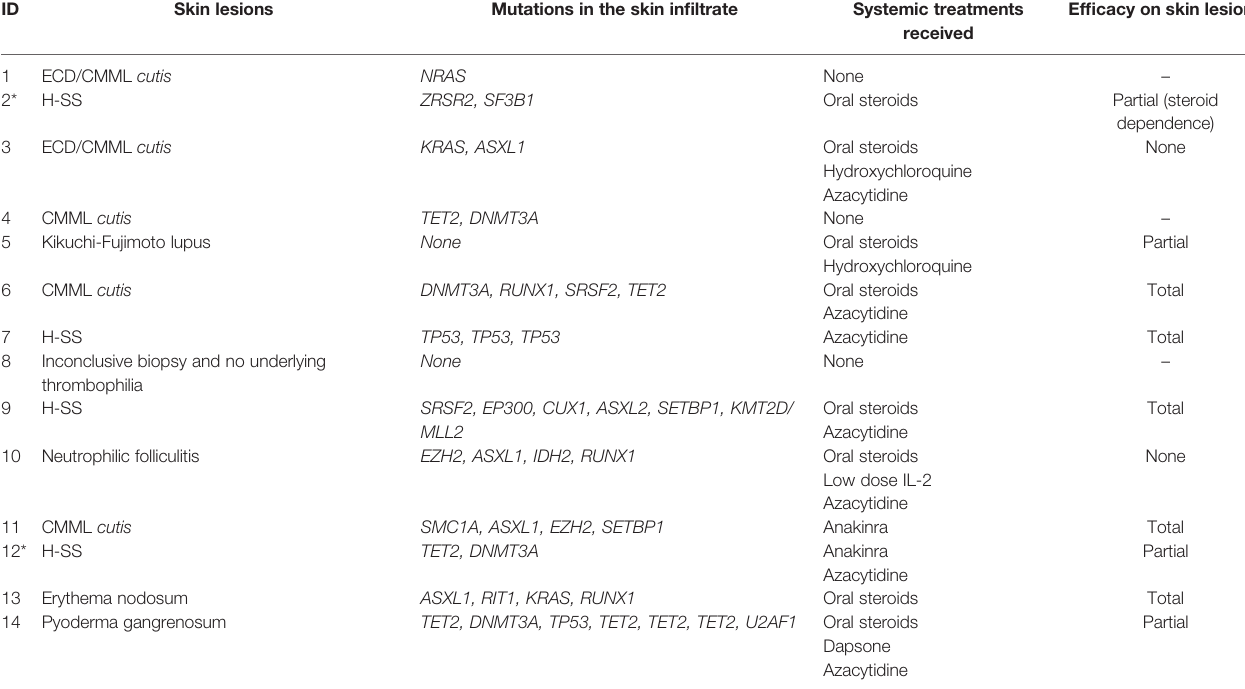
TABLE 4 | Treatment outcome in skin lesions associated to